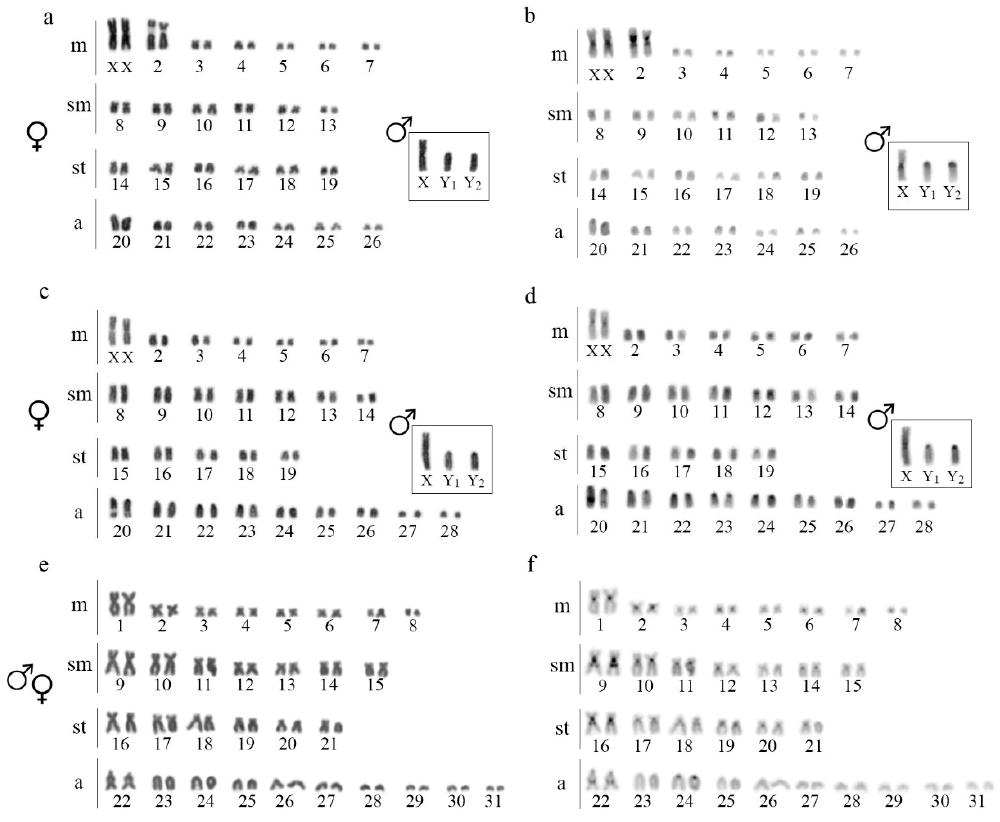
Figure 2. Karyotypes of H. intermontana ( a , b ), Harttia sp. 1 ( c , d ), and Harttia sp. 2 ( e , f ), showing sequentially Giemsa-stained ( a , c , e ) and C-banded ( b , d , f ) chromosomes. Insets depict the male sex chromosomes. Bar = 5 μ m.